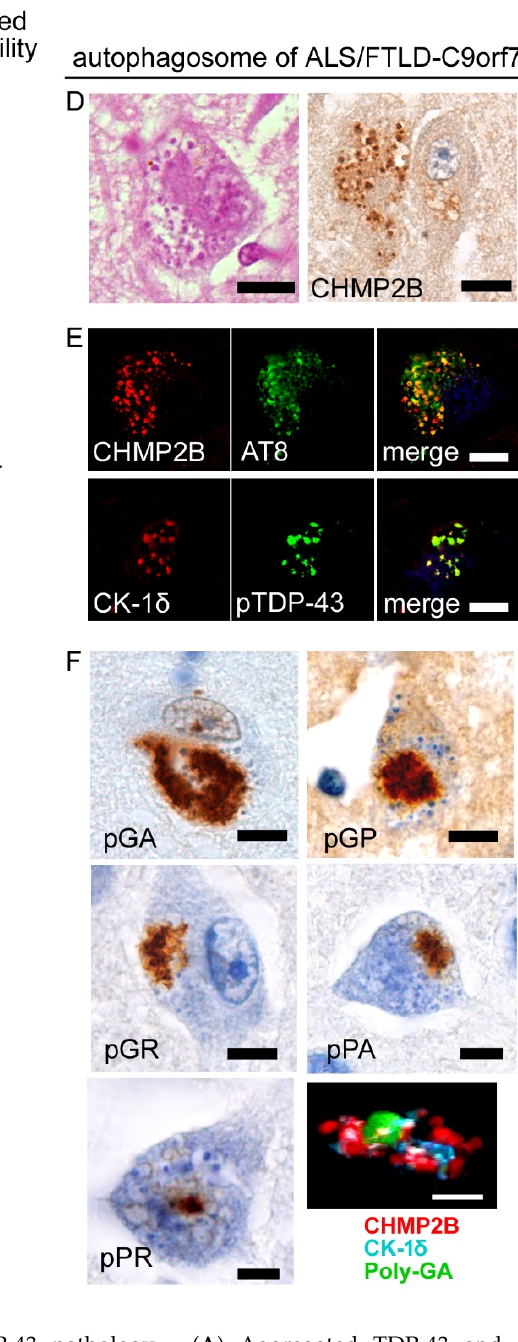
Figure 4. Endosome-autophagosome system and TDP-43 pathology. ( A ) Aggregated TDP-43 and dysfunction/haploinsufficiency of ALS/FTLD-TDP-related genes have been reported to impair maturation, transport, or fusion of endosomal and autophagosomal vesicles. ( B ) The exosomal fraction of brain lysates from ALS-TDP patients contains abundant TDP-43, particularly C-terminal fragments. ( C ) Neuro2a cells that were treated with ALS-patients-derived exosome and transfected with human-derived TDP-43 exhibited cytoplasmic aggregation of TDP-43. ( D – F ) These panels show neuropathologic changes of ALS/FTLD-TDP patients carrying C9-orf72 hexanucleotide expansions. Hippocampal pyramidal neurons often displayed granulovacuolar degeneration (GVD) that was associated with immunoreactivity for CHMP2B, a marker of multivesicular bodies (MVBs) ( D ). GVD granules, which were immunolabeled with CHMP2B and CK1δ, contained p-TDP-43 and hyperphosphorylated tau ( E ). Mutation-derived sense (poly GA, poly GP, and poly GR) and antisense dipeptides (poly PR and poly PA) were frequently covered with CHMP2B-immunopositive GVD granules. Scale bars: 10 μm. ALS-TDP- or FTLD-TDP-related genes, including SQSTM1 ( p62 ), UBQLN2 , VCP , GRN , and OPTN , are important players in the autophagy system [75]. Indeed, homozy-